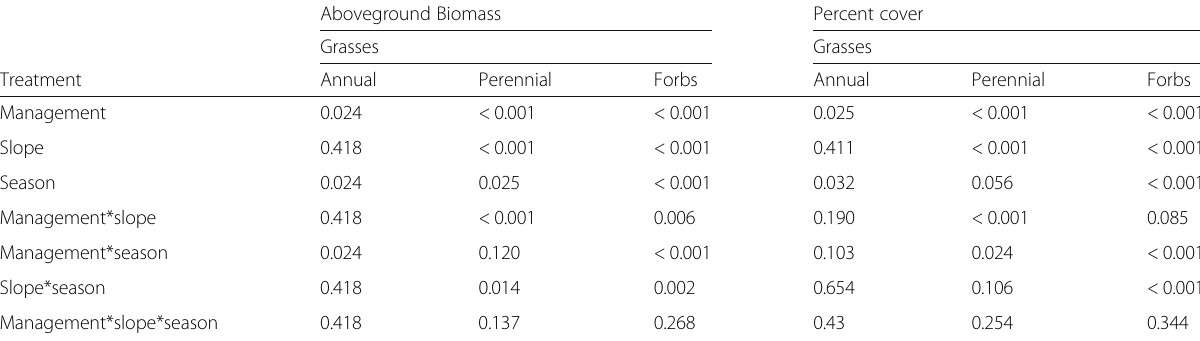
Table 5 Response of aboveground biomass production and percent cover to management, slope, season, and their